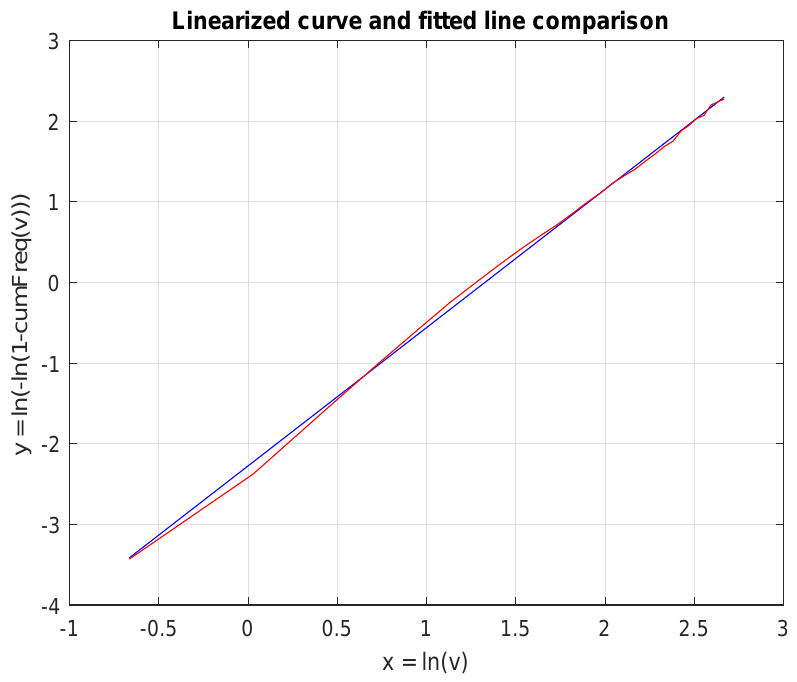
Figure 23. The portraits of linearized curve and fitted line comparison in OSWFs in Yangshan port, Shanghai from 22 August 2017 to 22 August 2018.